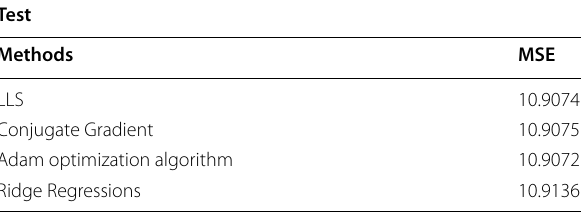
Table 5 MSE results of the test